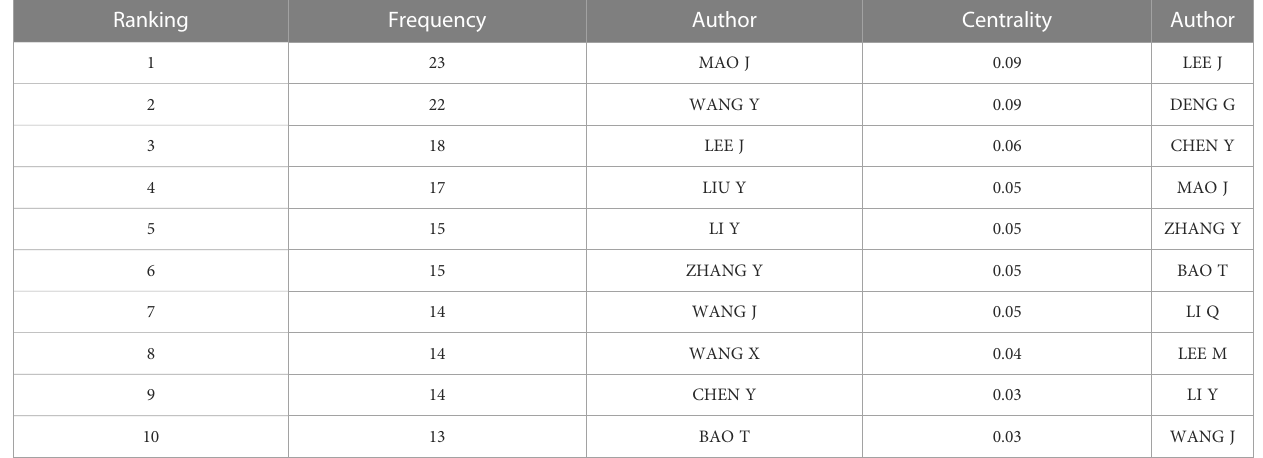
TABLE 4 Top 10 authors of studies on acupuncture for cancer pain.